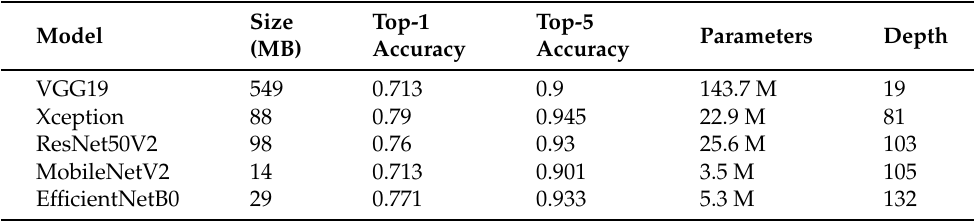
Table 1. Model accuracy, parameters, and